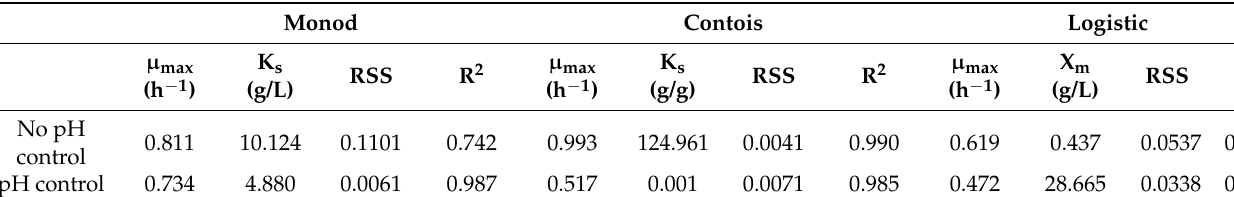
Table 3. The growth kinetic constants of Monod, logistic, and Contois models ( µ max : maximum specific growth rate; K s : semi-saturation constant; X m : maximum biomass concentration), the residual sum of squares RSS, and the correlation coefficient R 2 , calculated for fermentations with and without pH control.